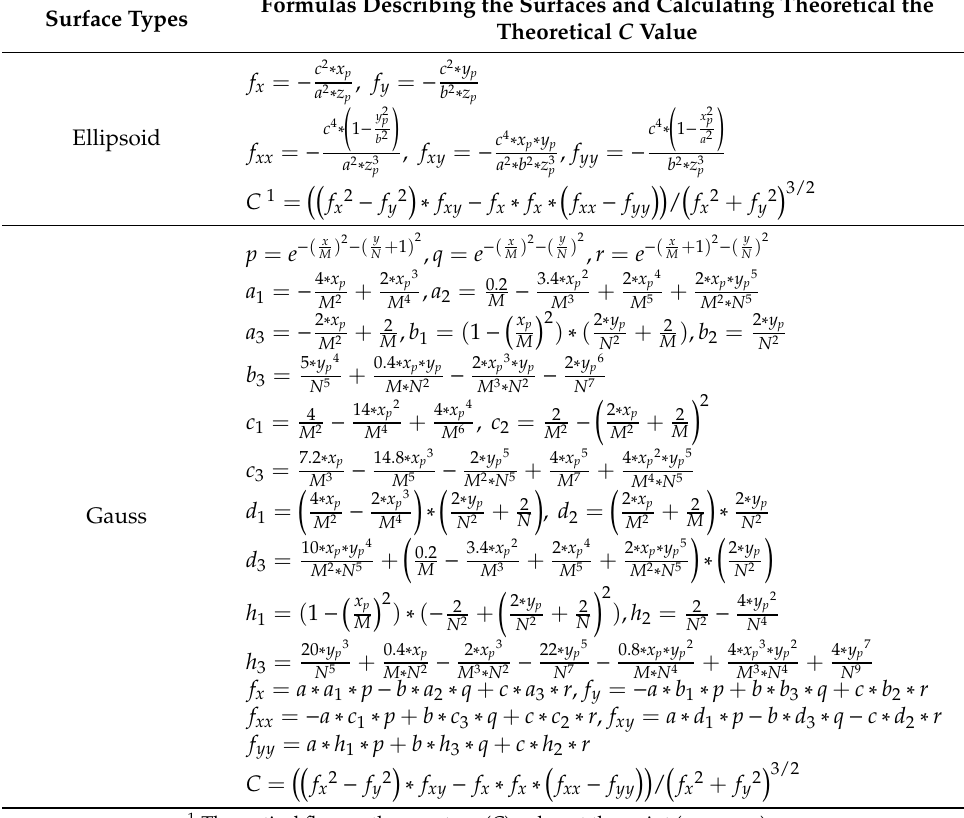
Table 2. Formulas describing the two mathematical surfaces and calculating the theoretical C